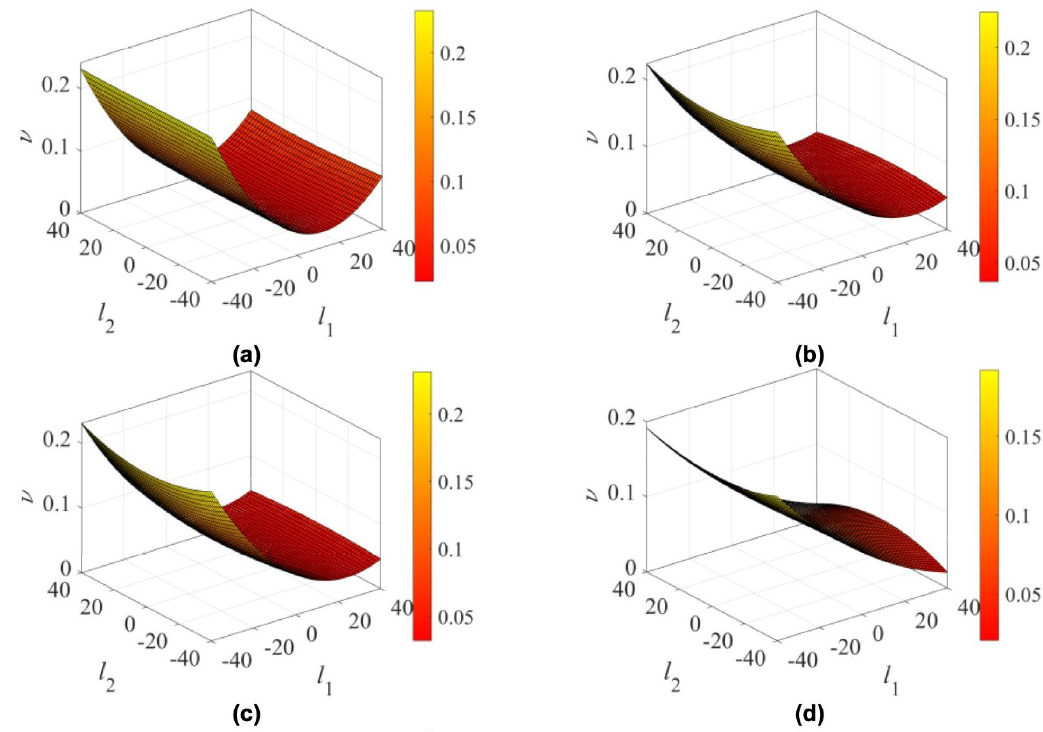
Figure 9: Pressure mode #1 for square plan with θ = 90 ∘ and geometry G 1 (a), G 2 (c), G 3 (b), G 4 (d), referring to Table